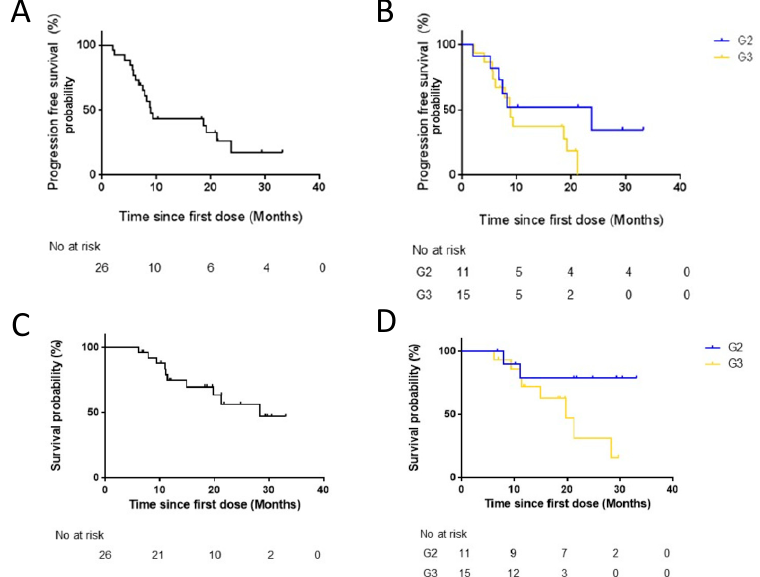
Figure 2. Time-to-outcome analyses. Curves of progression-free survival and overall survival in all patients ( A and C ) and according to grading ( B and D ).